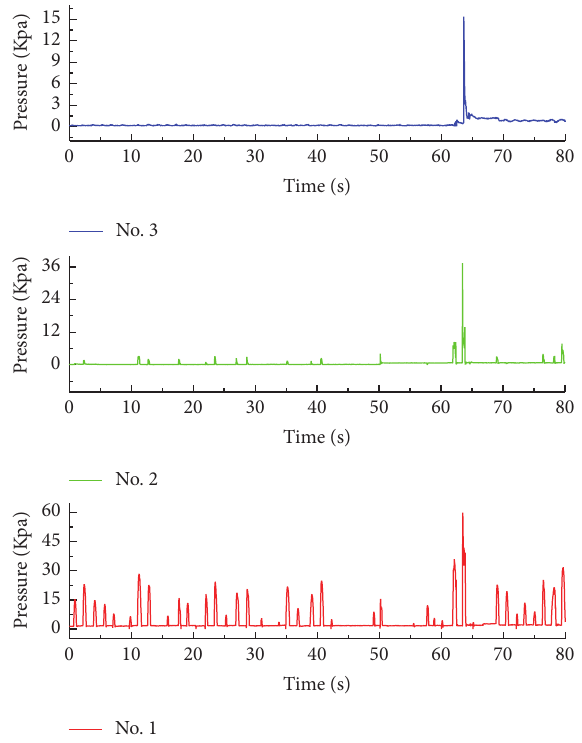
Figure 38: Time histories of pressure in bow sea.